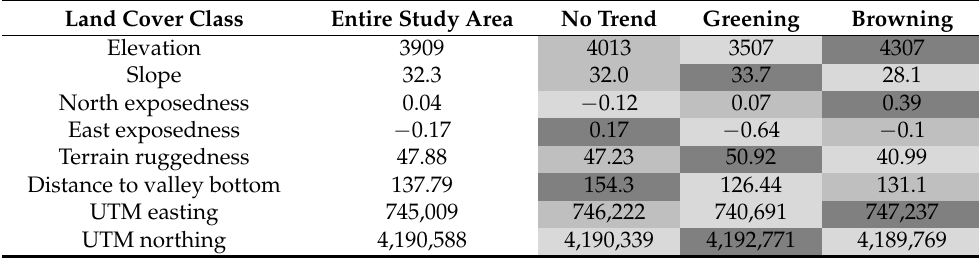
Table 4. Median of topography variables in relation to trend type. Different shades of grey indicate a significant difference between the values of classes based on Mann–Whitney U-Test.